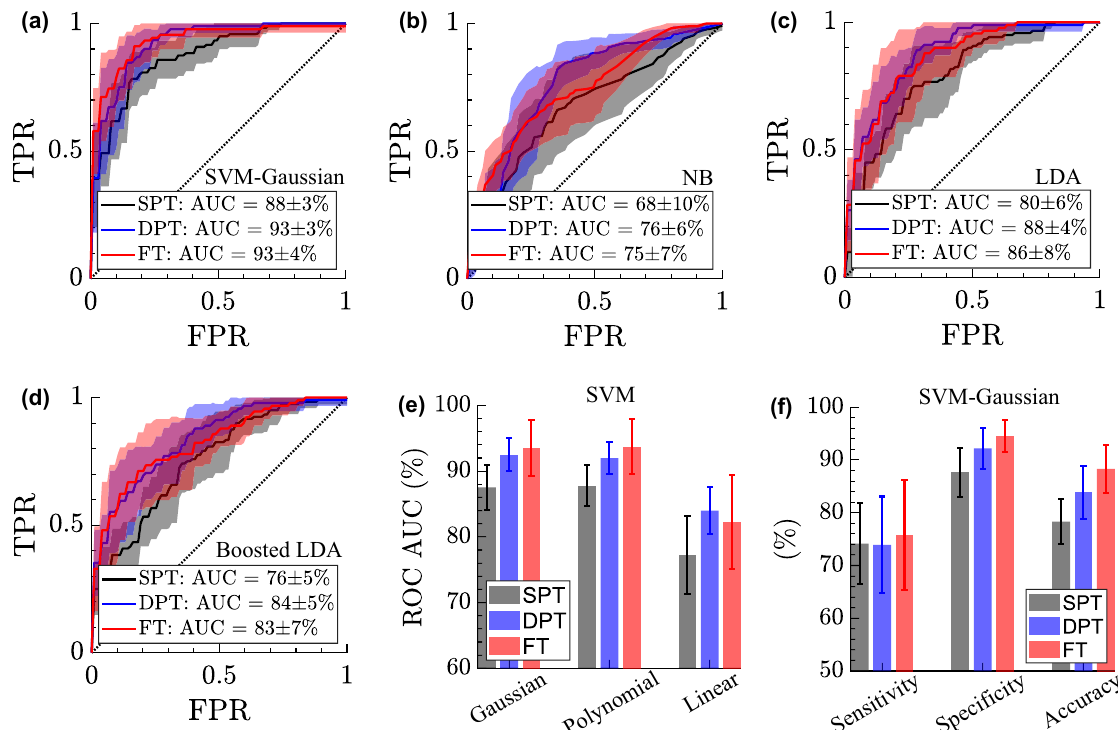
Figure 6. ( a – d ) The ROC curves obtained using the Gaussian Support Vector Machine (SVM), Naive Bayes (NB), Linear Discriminant Analysis (LDA), and AdaBoosted LDA classifiers for identification of SPT (black lines), DPT (blue lines), and FT burns (red lines), ( e ) comparison of the area under the ROC curves obtained using the SVM classifiers with Gaussian, polynomial (quadratic, cubic, and the fourth power), and linear kernel functions, ( f ) the sensitivity, specificity, and accuracy rates in classification of each burn group obtained using the Gaussian SVM, the error bars in the ROC curves and the bar plots show the standard deviation over the 10 iterations of each classifier with different random ROIs selected during each